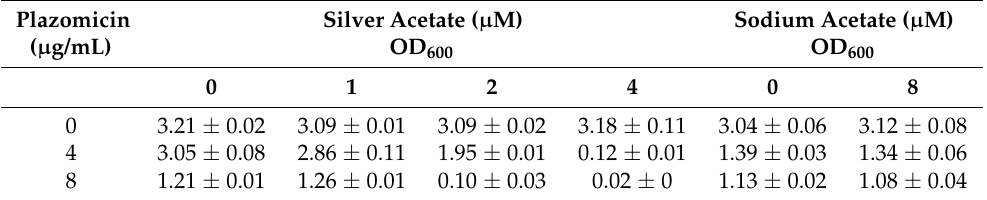
Table 1. Growth in the presence of plazomicin and silver acetate.